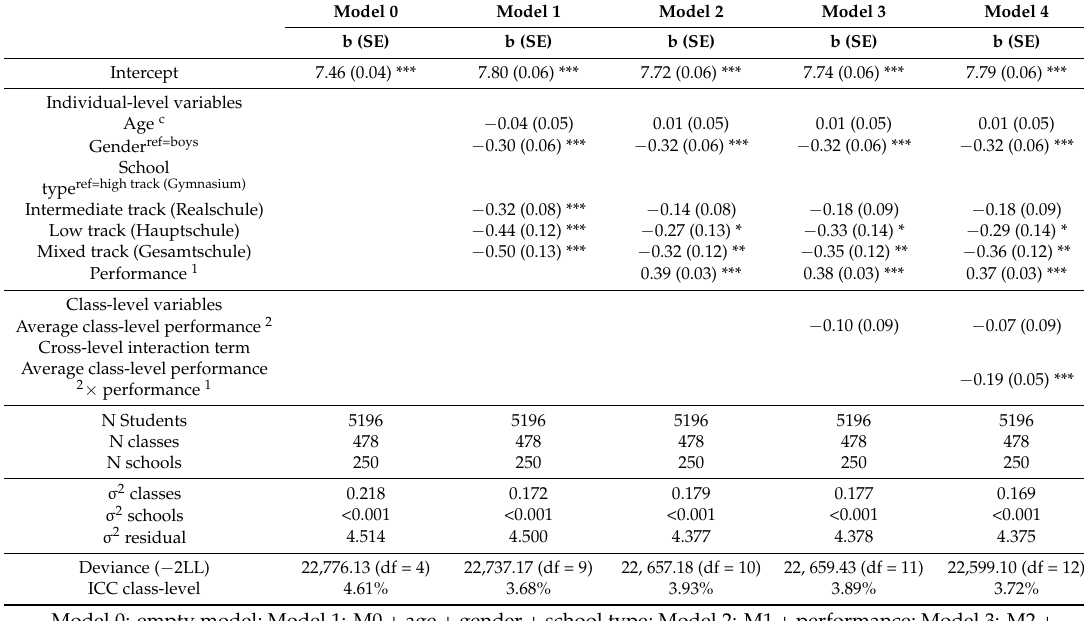
Table 2. Linear mixed models for students’ life satisfaction (n = 5196 students, in 478 classes, in 250